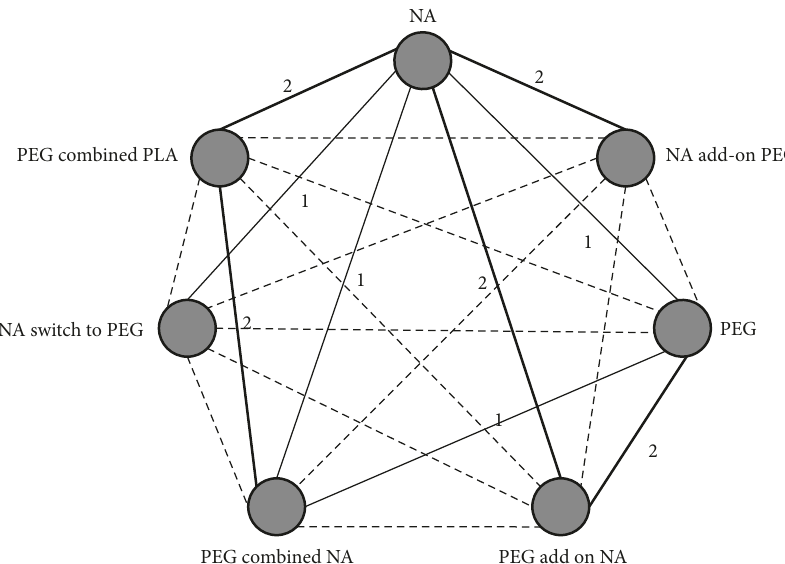
Figure 2: Network of trial comparisons for NA, NA add-on PEG IFN, PEG IFN, PEG IFN add-on NA, PEG IFN combined NA, NA switch to PEG IFN, PEG IFN combined PLA. NA, nucleoside/nucleotide analogs; PEG IFN, pegylated interferon; PLA, placebo. Numbers represent that number of direct comparisons available. Dashed lines indicate indirect treatment